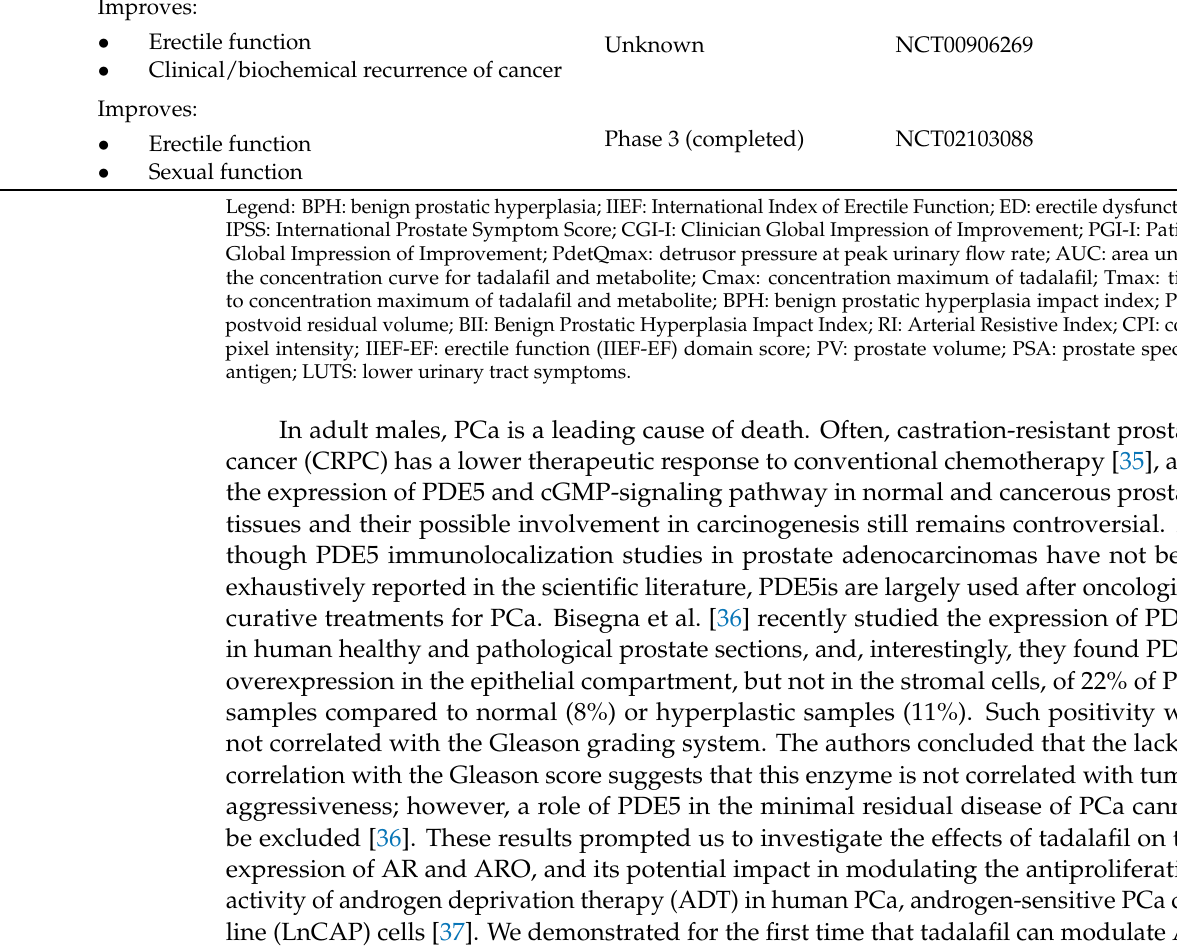
ClinicalTrials.gov